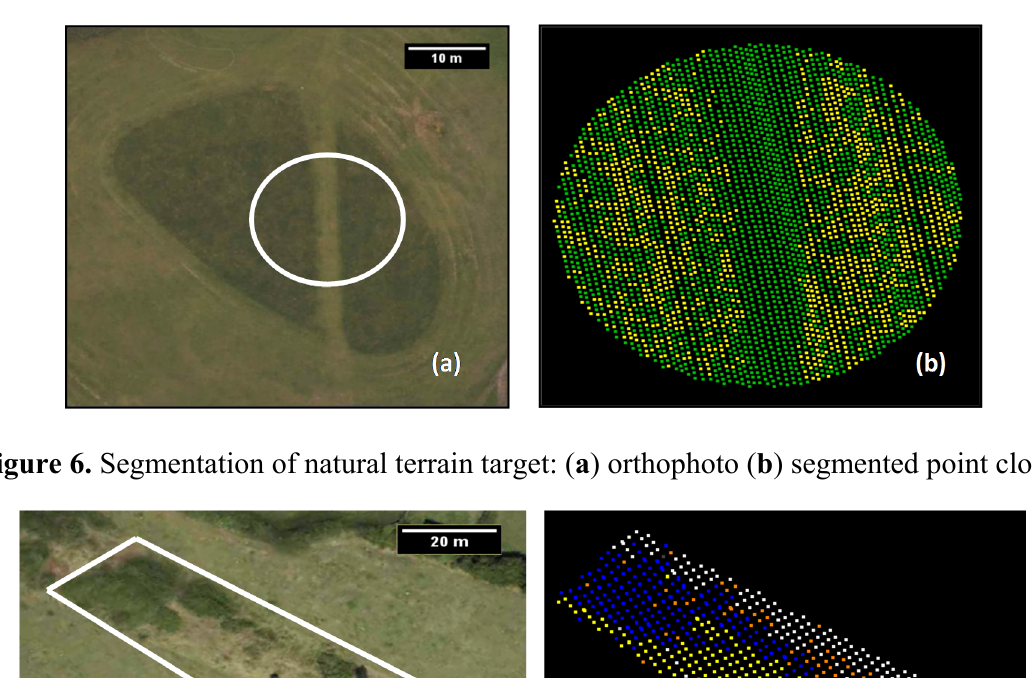
Figure 5. Segmentation results of a mown grass target: ( a ) orthophoto ( b ) segmented point cloud.